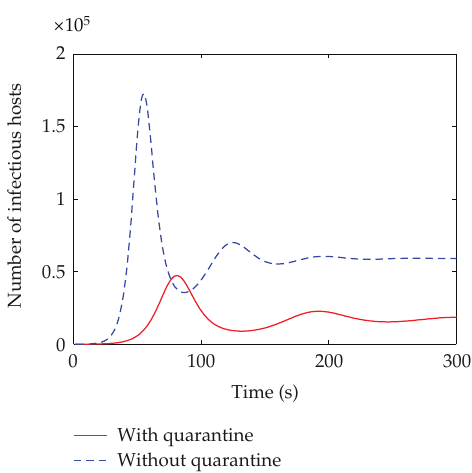
Figure 3: Comparison of infectious hosts before and after adopting quarantine strategy if τ < τ 0